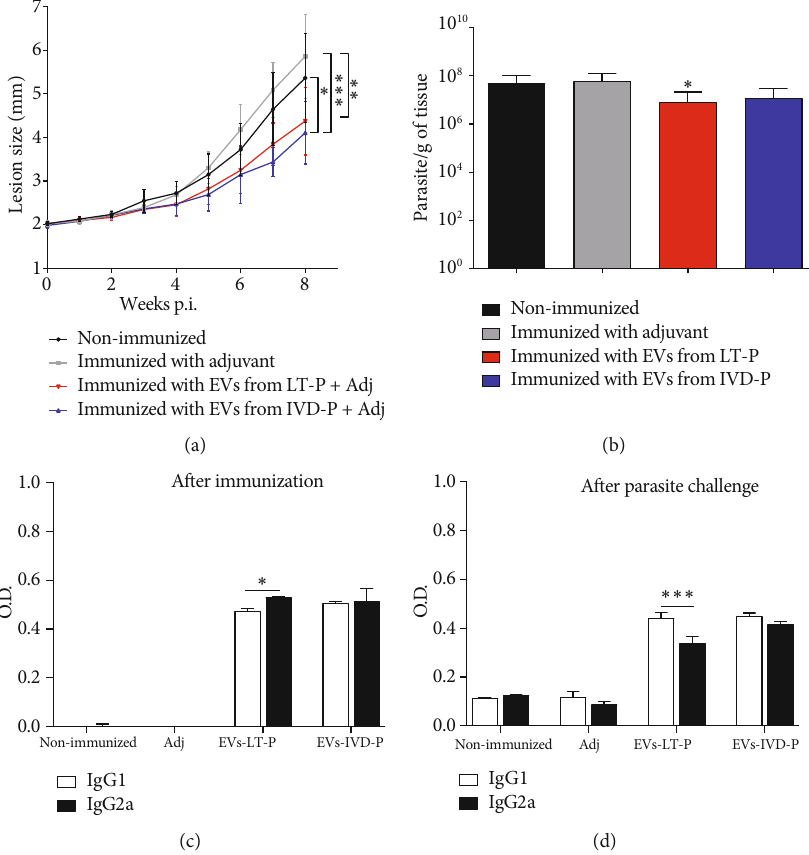
Figure 7: BALB/c mice were treated with the 3-dose protocol. (a) Lesion size (millimeter (mm)) measurements ( n = 9 ). Each point represents the average of the measurements. ANOVA followed by post hoc Tukey ’ s test; ∗ P < 0 : 05 : nonimmunized infected mice compared with IVD-P; ∗∗ P < 0 : 01 : adj compared with mice immunized with LT-P; ∗∗∗ P < 0 : 001 : adj compared with the group immunized with IVD-P. (b) Parasite load ( n = 9 ). Bars denote the average of 9 measurements, and error bars denote the SD. Kruskal- Wallis test followed by Dunn ’ s test, ∗ P < 0 : 05 compared with nonimmunized mice. (c) Production of IgG1 and IgG2a isotype antibody anti-EVs. (d) Measurements of the IgG1 and IgG2a isotype anti-total extract of L. amazonensis in mice immunized and infected with the parasite. Bars represent the average of 9 measurements, and error bars show the SD. Two-way ANOVA followed by post hoc Sidak ’ s test ð ∗ P <0 : 05and ∗∗∗ P < 0 : 001IgG1 versusIgG2a in eachgroup Þ . Nonimmunized: nonimmunized infected mice; Adj: mice immunized with adjuvant; EVs-LT-P: mice immunized with EVs released by LTP-P; EVs-IVD-P: group of mice immunized with EVs from IVD-P. Data are representative of 2 independent